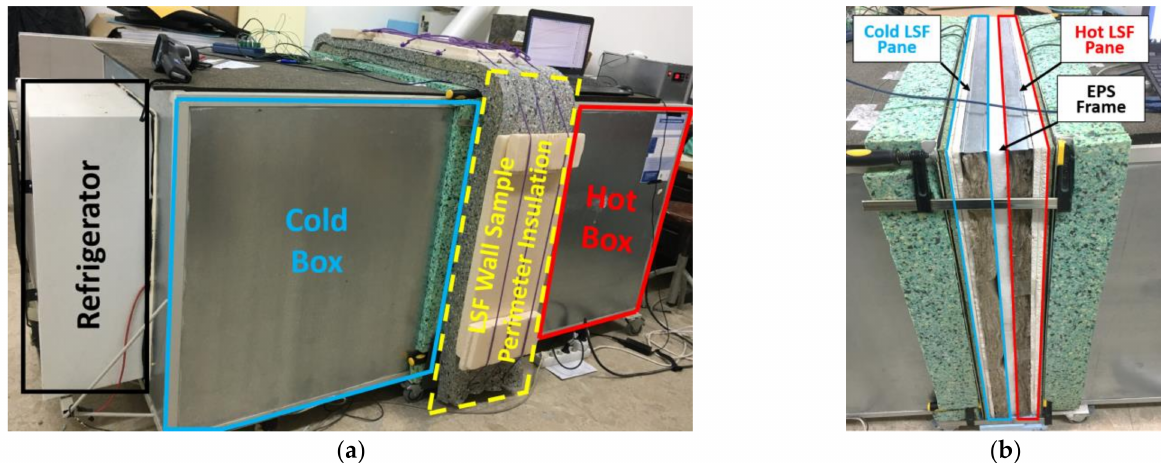
Figure 2. Mini hot box apparatus used in the lab measurements. ( a ) Lateral view with sample perimeter insulation; ( b ) LSF wall test